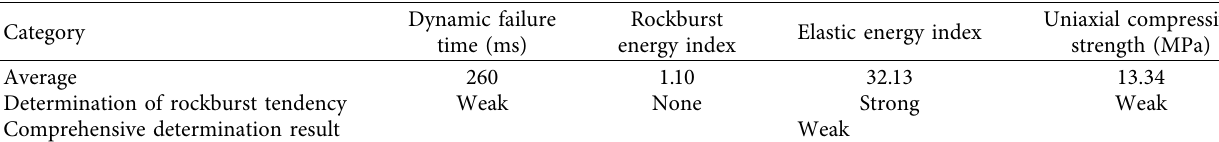
Table 2: Appraisal results of coal seam 4-5 rockburst